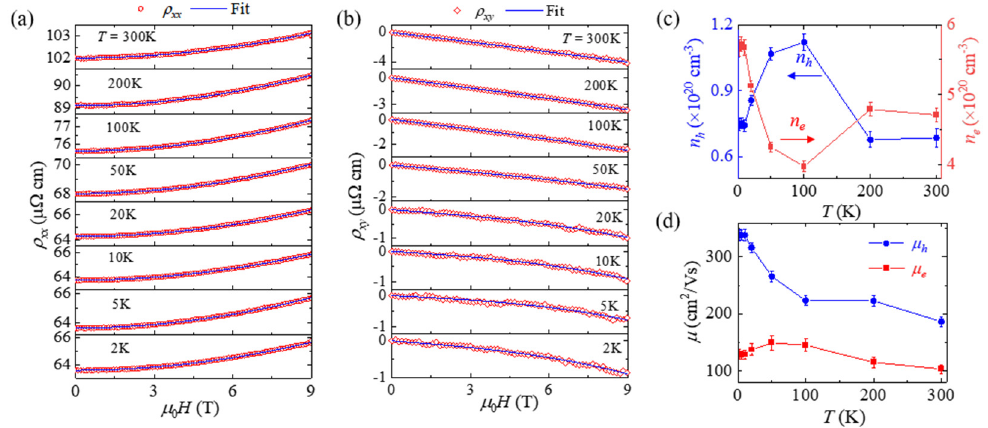
Figure 3. ( a , b ) Simultaneous fits for ( a ) longitudinal resistivity ρ xx and ( b ) transverse resistivity ρ xy using the two-band model. ( c ) Temperature dependent electron and hole carrier densities obtained from the fits. ( d ) Temperature dependent electron and hole carrier mobilities obtained from the fits.